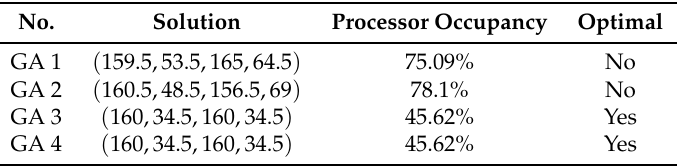
Table 6. Optimization result of Experiment